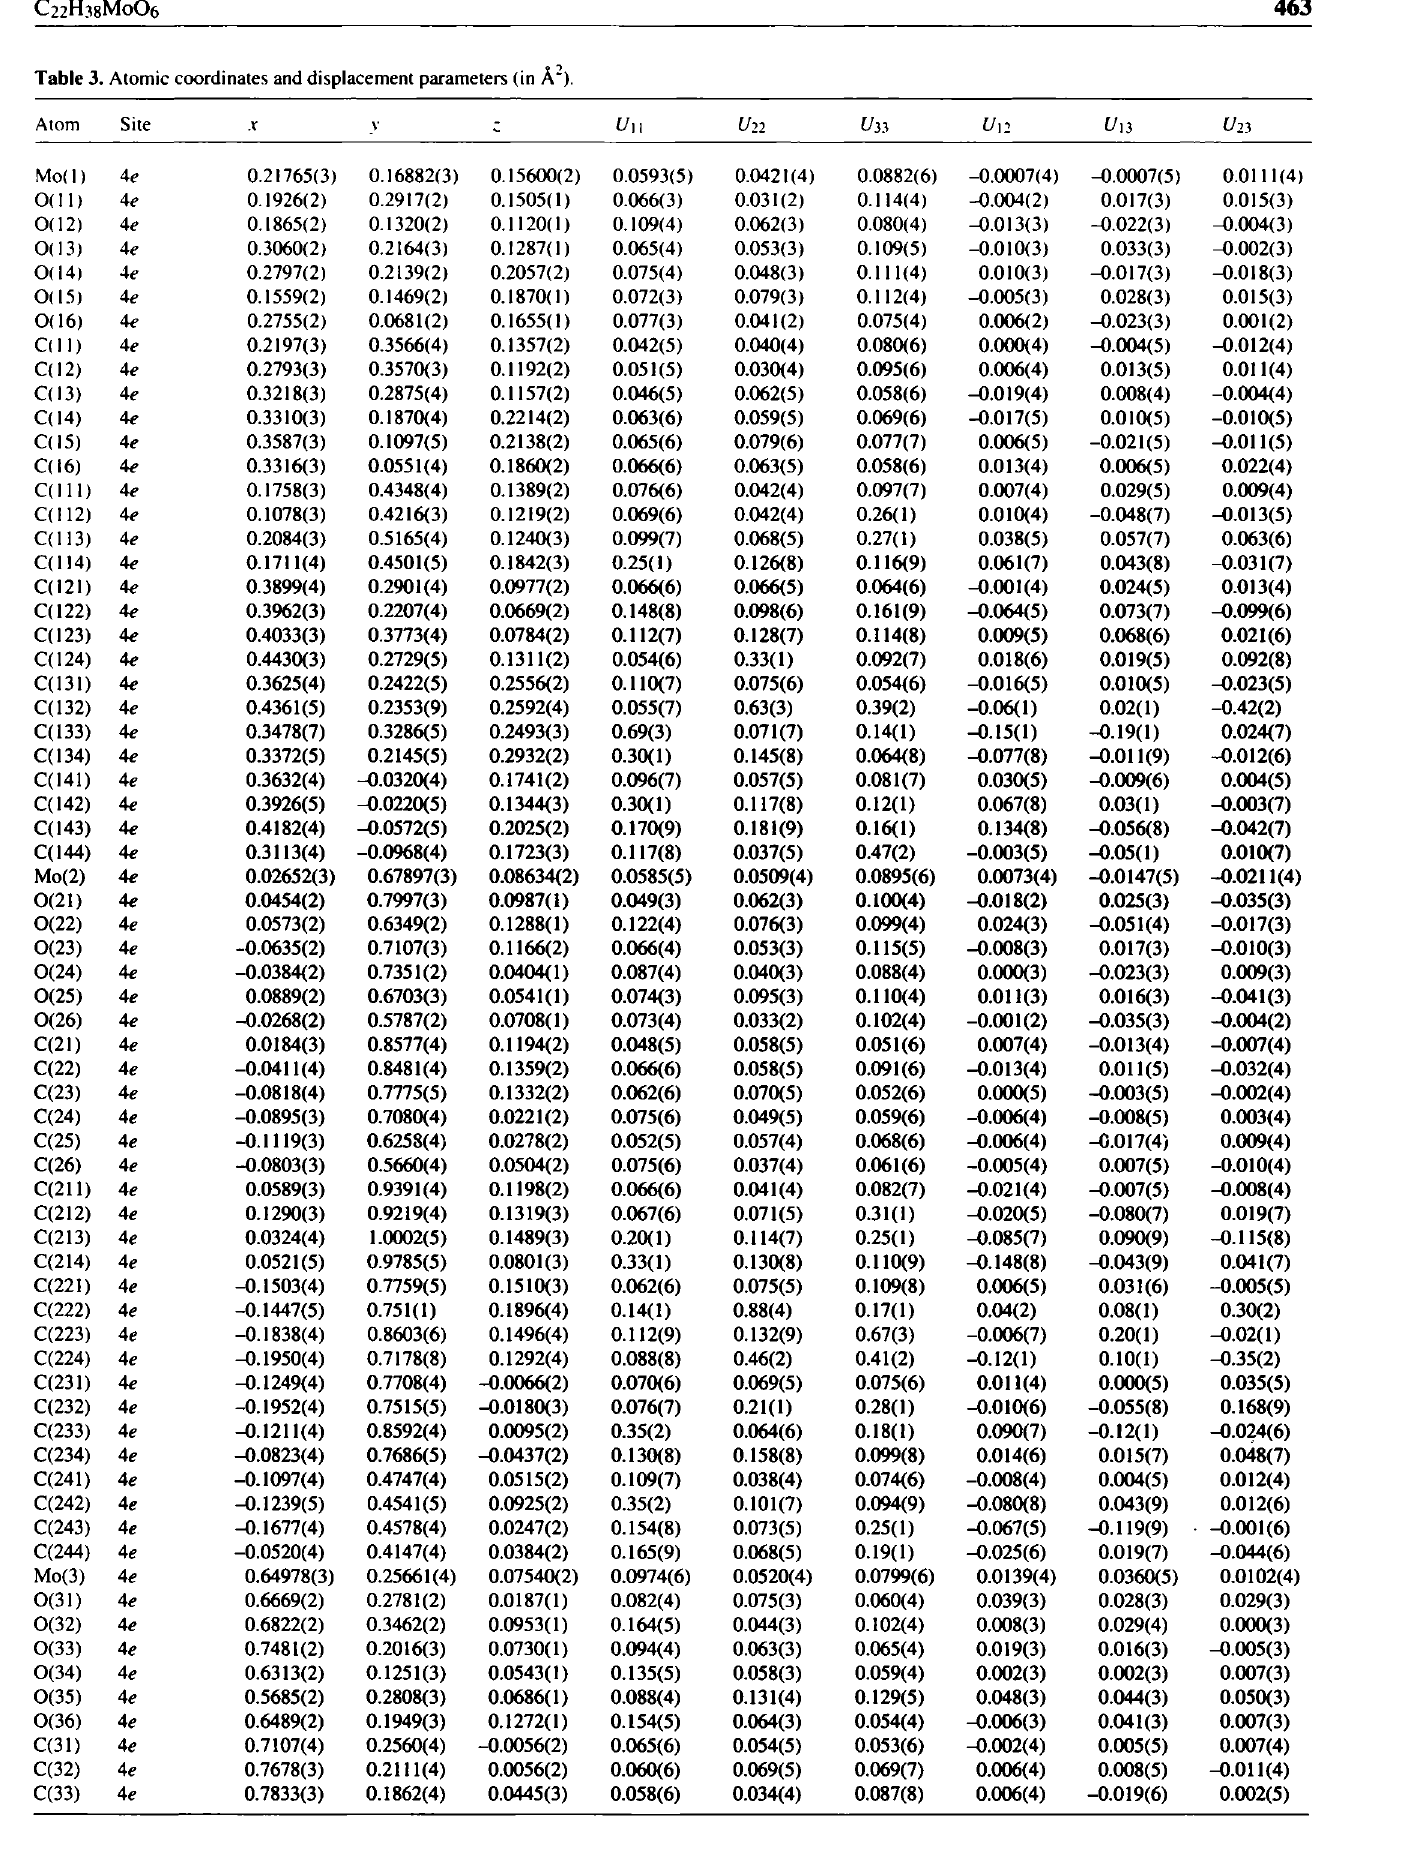
Table 3. Atomic coordinates and displacement parameters (in Ä 2